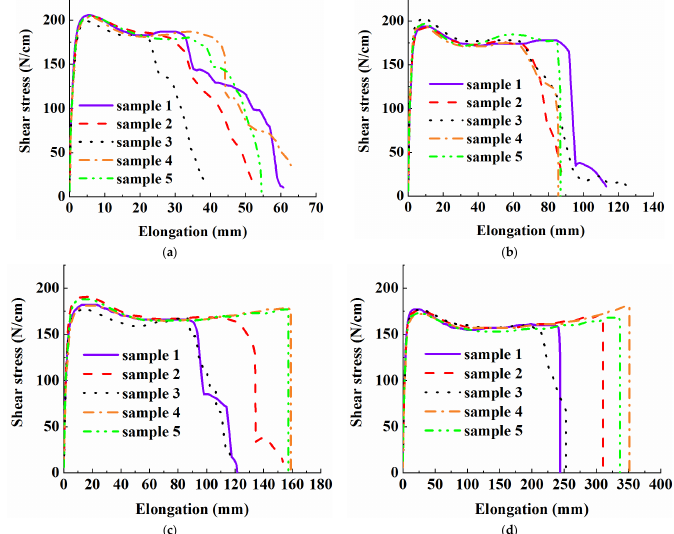
Figure 11. Shear stress–elongation relationship of the junction subjected to shear force under various clamping distances: ( a ) 10.5 mm, ( b ) 25 mm, ( c ) 50 mm, ( d ) 100 mm.